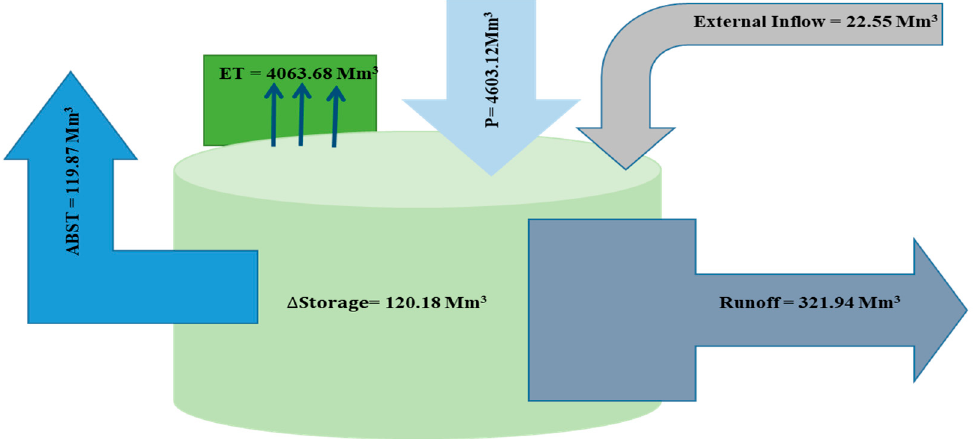
Figure 10 . Water balance model for Chongwe River Catchment for 2016/17 . Table 8. Estimated annual water balance components for Chongwe River Catchment for selected years.